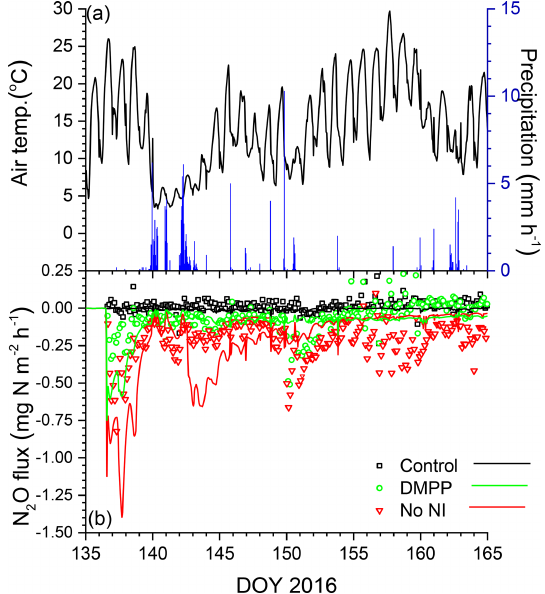
Figure 7. (a) Air temperature and precipitation and (b) N 2 O fluxes measured (symbols) and modelled (lines) during spring 2016 with no slurry (control) and following slurry application on DOY 137 in 2016 with or without DMPP. Negative values denote